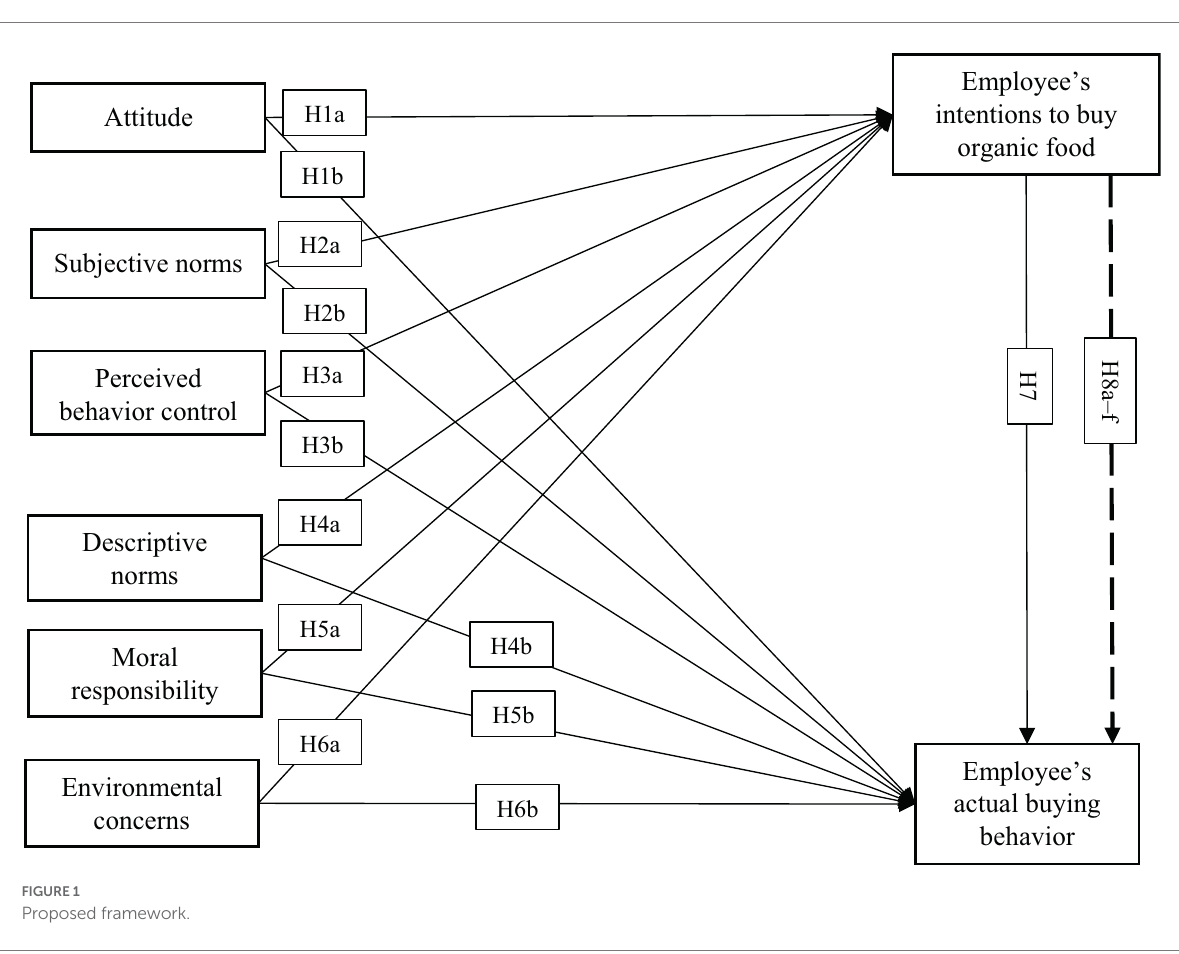
FIGURE 1 Proposed framework.